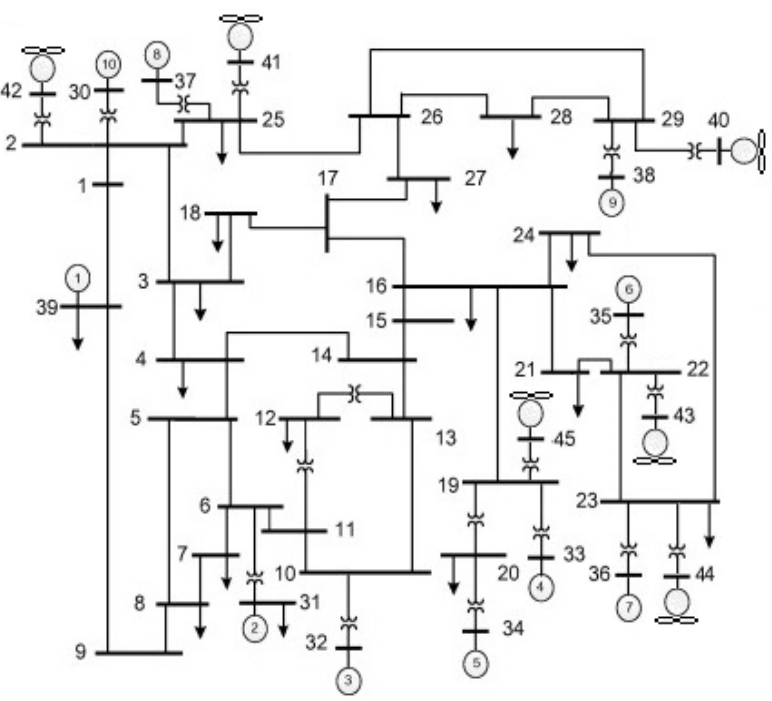
Figure 9. Application of a preventive control scheme for local and systemic actions.